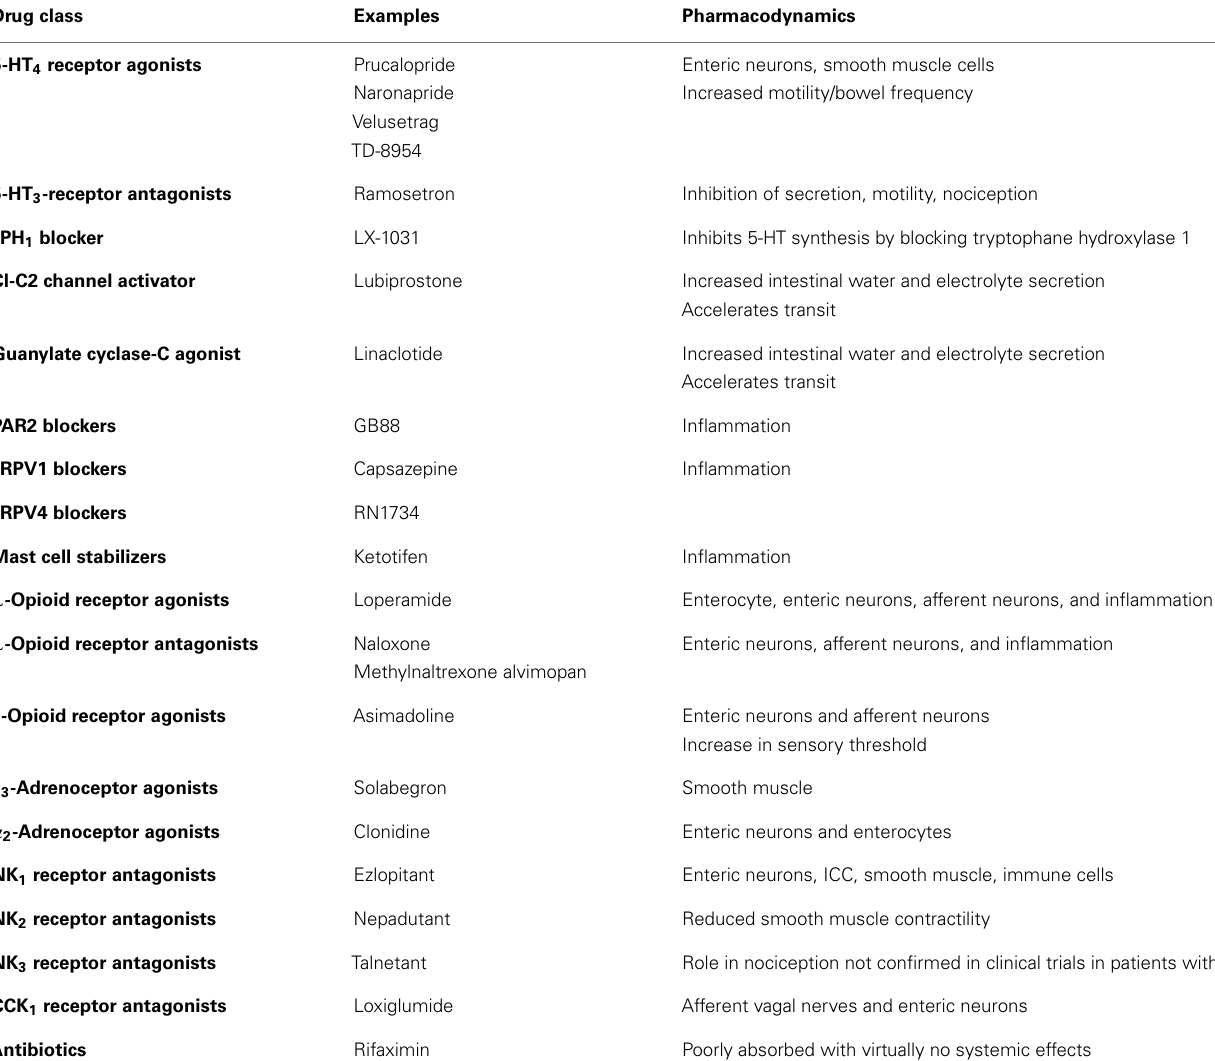
Table 2 | Main pharmacological approaches in